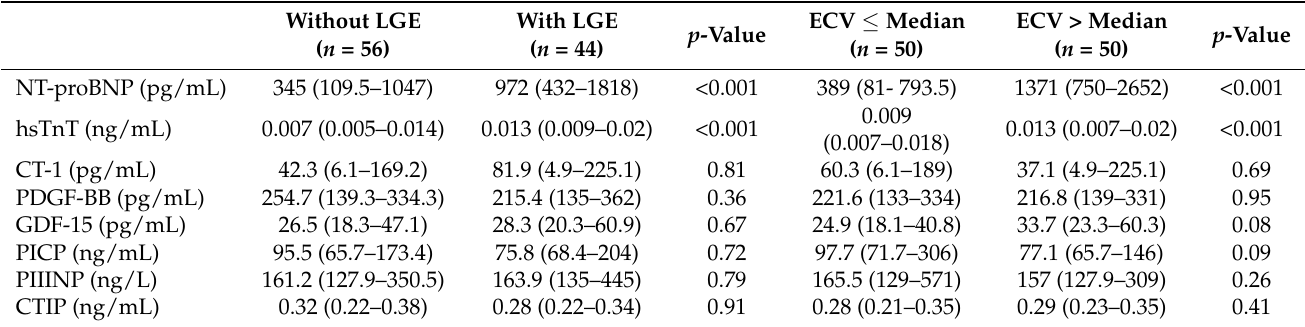
The final study population consisted of 100 DCM patients with complete data. There were 44% patients with LGE and the median ECV was 27.7%. Patients were divided according to the presence of LGE and their median value of ECV. The comparison of the baseline parameters between DCM patients with and without LGE, and between groups from lower and upper ECV strata, is presented in Table 1. Patients with LGE differed from those without LGE in terms of the prevalence of hypertension, chronic obstructive pulmonary disease, diastolic blood pressure, QRS width, thickness of interventricular septum, left atrial area, E/E’ ratio, LV mass, native T1 times, ECV, hematocrit, white blood count, uric acid, and loop diuretic daily dosages. Patients from the lower ECV strata differed from those in the upper ECV strata in terms of the following: age, atrial fibrillation, ventricular arrhythmia, distance in the 6-min walk test, left and right atrial areas, prevalence of at least moderate mitral and tricuspid regurgitation, LGE extent, native and post-contrast T1 times, blood levels of uric acid and cholesterol, and loop diuretic